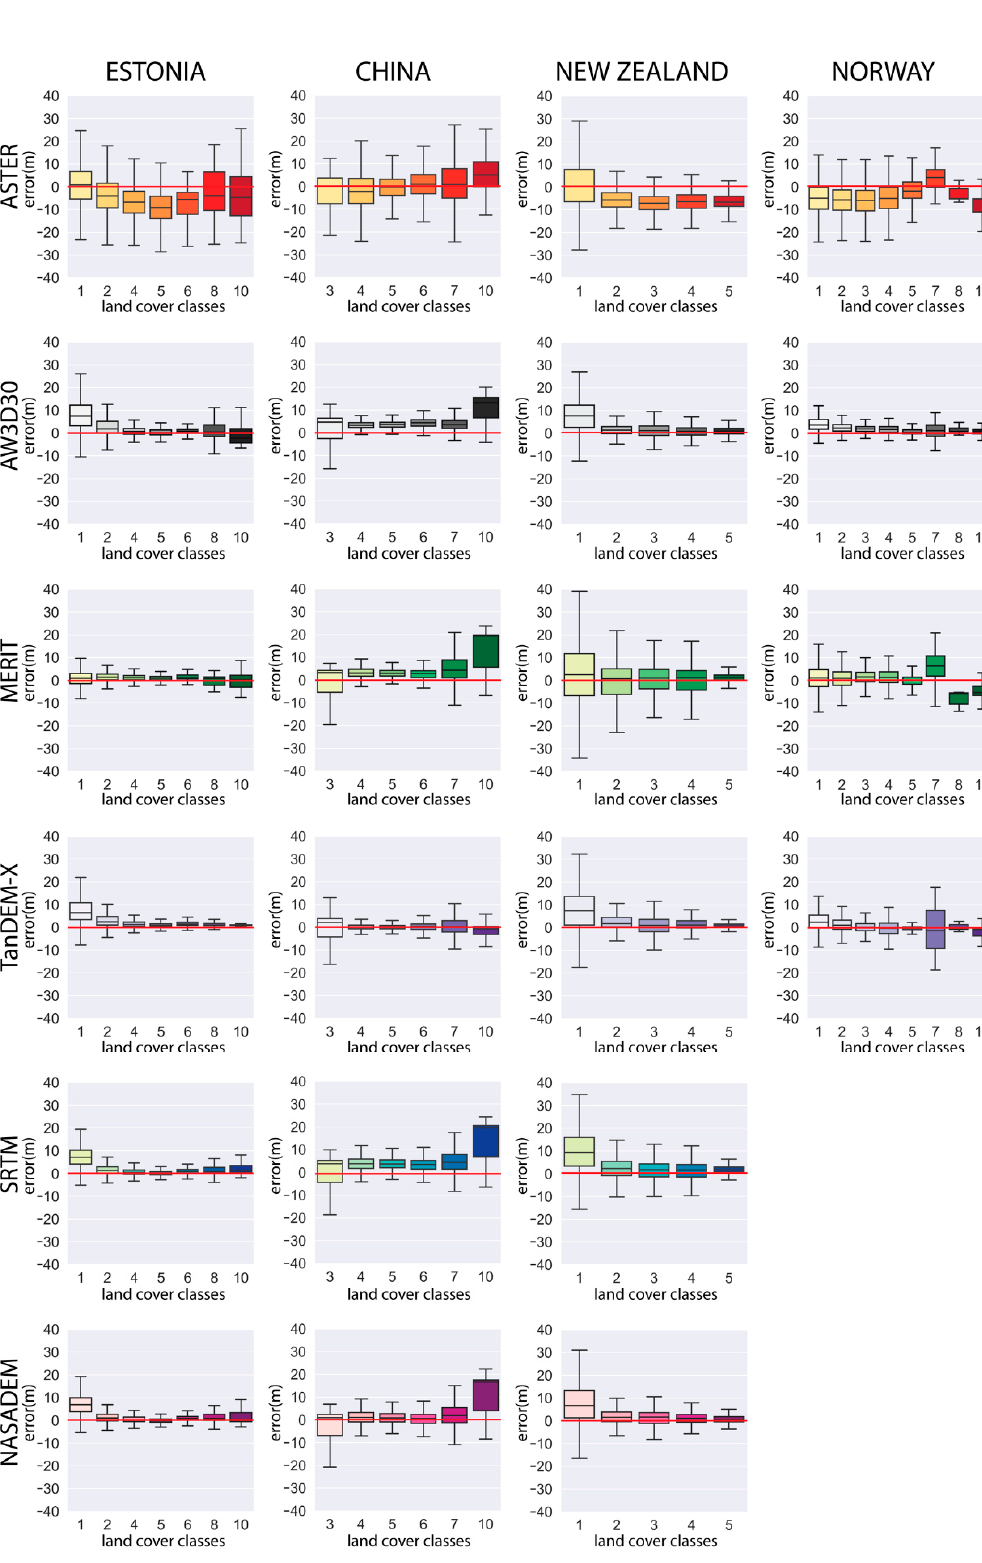
Figure 6. Box plots of errors by land cover class for all global digital elevation models for the four study areas. SRTM and NASADEM data were not available for the Norwegian study area because of its high latitude. Land cover classes: 1, Closed forest; 2, Open forest; 3, Shrubs; 4, Herbaceous vegetation; 5, Cultivated area; 6, Urban / built up area; 7, Bare land / sparse vegetation; 8, Wetland; 9, Snow and ice; 10, Water. Only existing land cover classes are plotted for each study area.